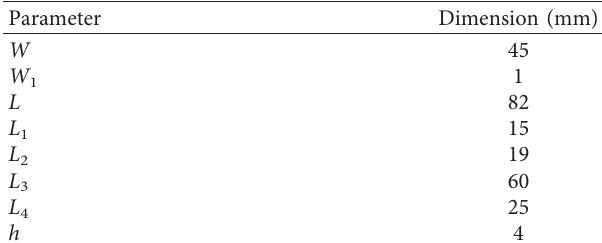
Figure 1: Configuration of the proposed tag: (a) top layer, (b) isometric view, (c) side view, and (d) PILA tag antenna with an RFID chip attached. Table 1: Optimized design dimensions of the proposed 3D PILA